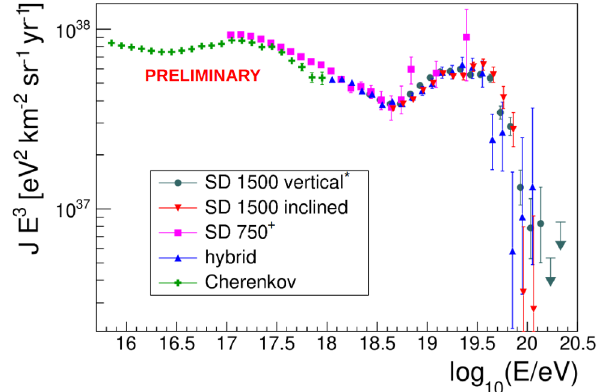
Figure 6. Five spectra of the Pierre Auger Observatory. Taken from Ref.